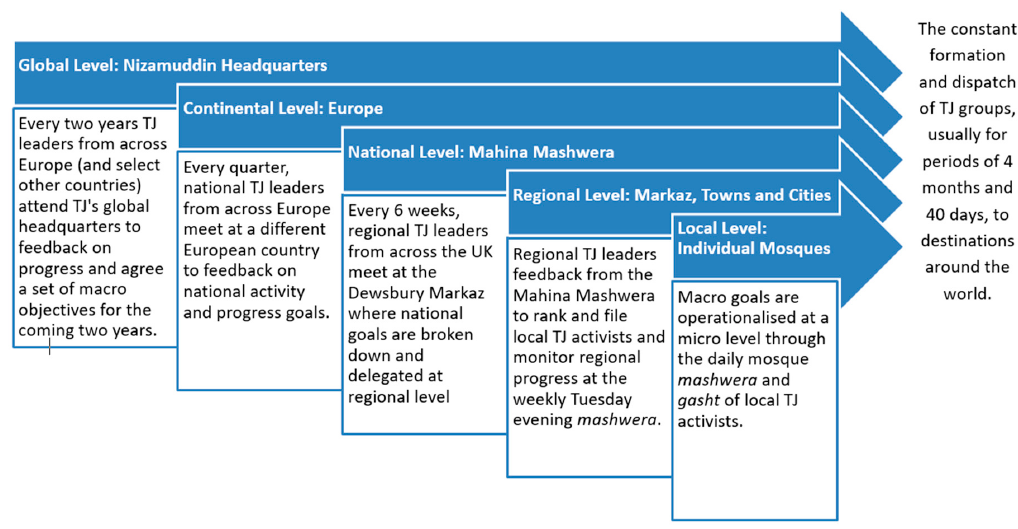
Figure 12. The mechanics of TJ’s “glocal” activism.